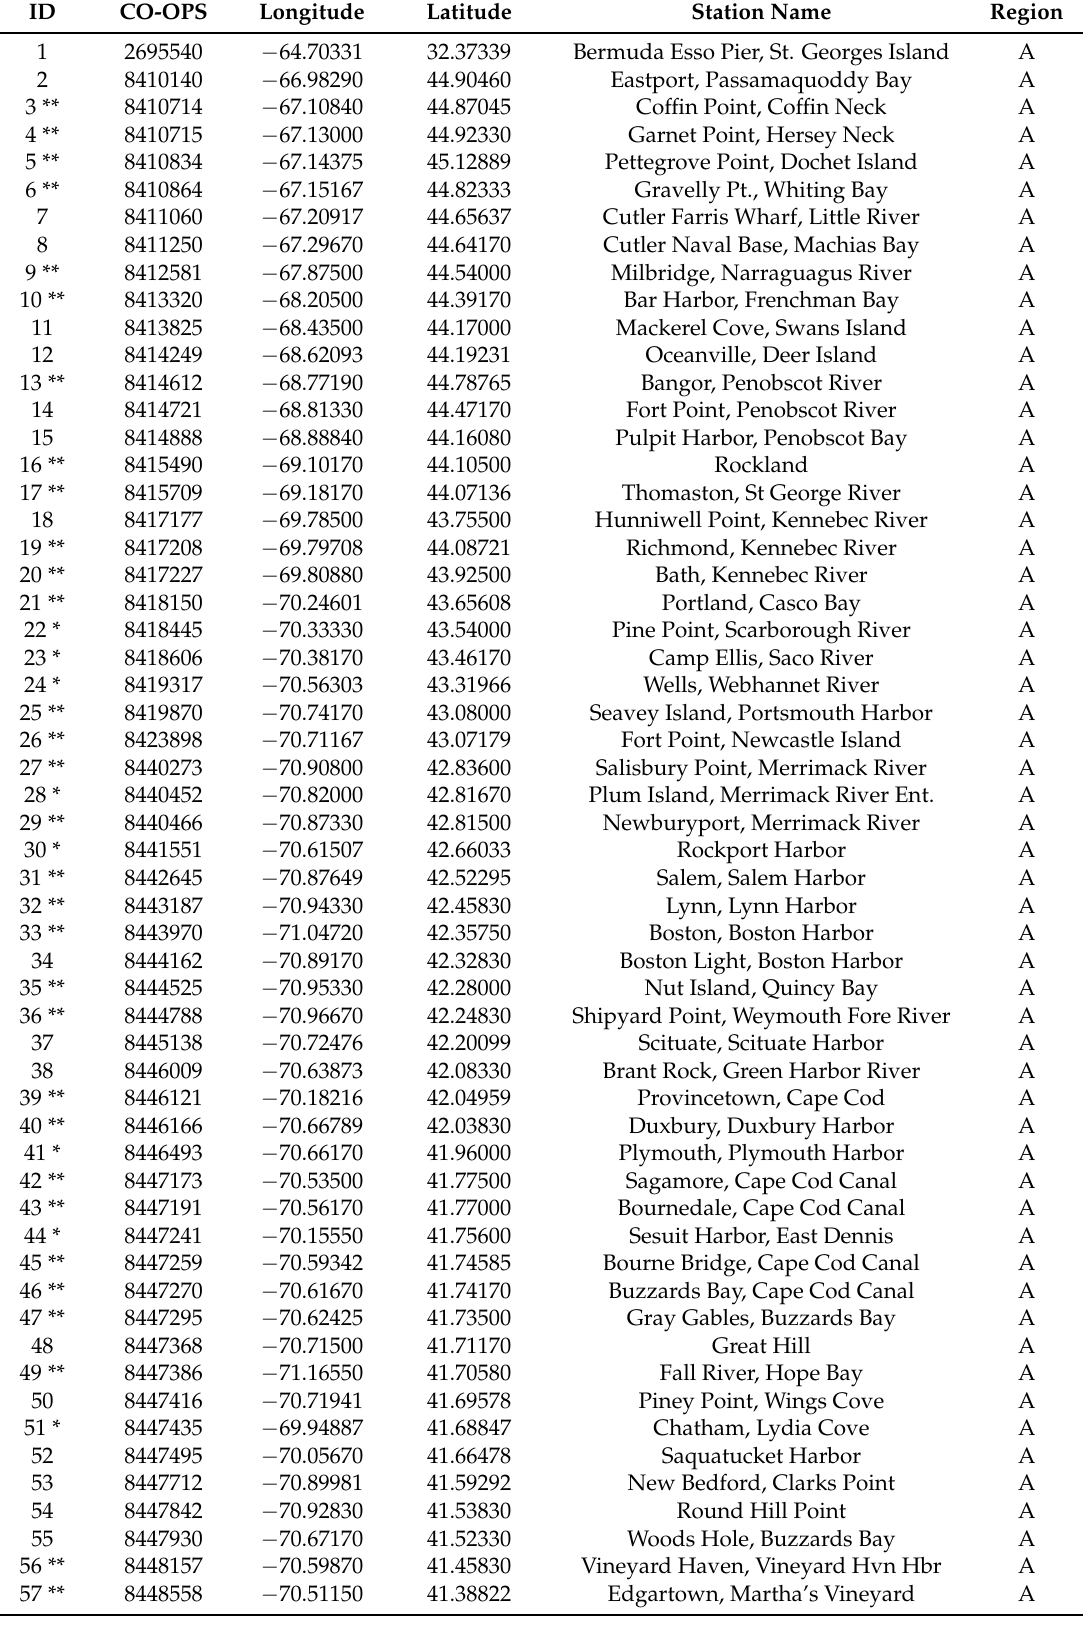
Table A1. Geographic location, name and regional classification for available validation